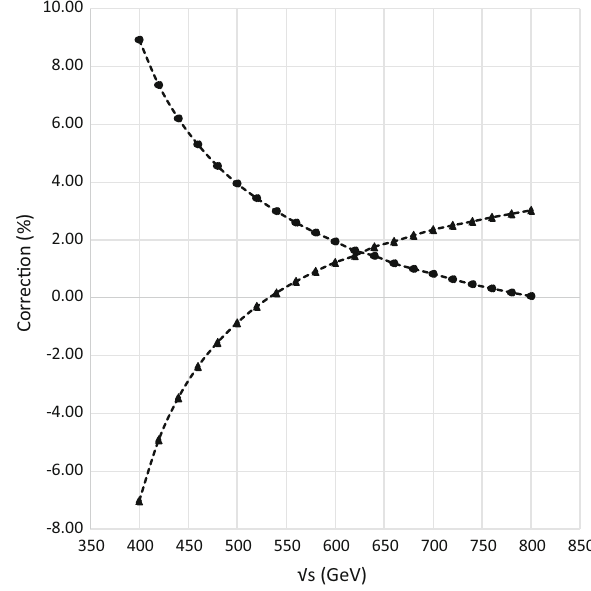
Fig. 2 The degree of correction for the full O (α) electroweak radiative corrections (dashed line with triangle points) and the weak corrections (solid line with circle points) correction degree is defined